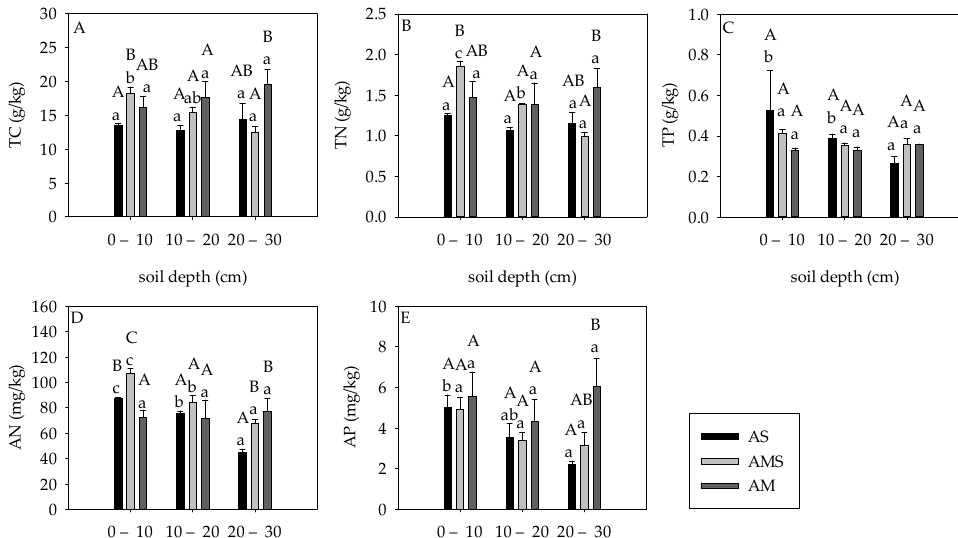
Figure 3. Soil carbon, nitrogen, phosphorus, AN, and AP content at different soil layers. ( A ) Soil TC content; ( B ) Soil TN content; ( C ) Soil TP content; ( D ) Soil AN content; ( E ) Soil AP content. Different capital letters indicate statistical differences at 0.05 level between different grassland types at the same depth. Different lowercase letters represent differences at the 0.05 level between different depths of the same grassland.